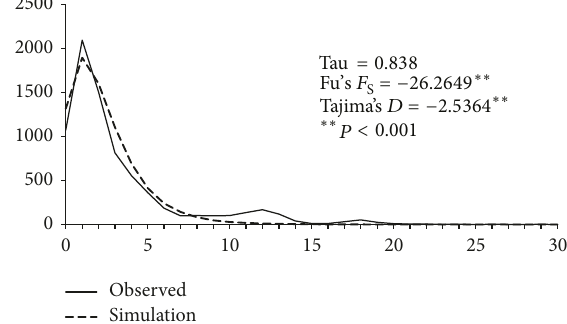
Figure3:Mismatchdistributionof124mitochondrialcytochromeb (cytb) sequencesof Belodontichthystruncatus representingobserved and expected pairwise differences under sudden population expan- sionmodel.Mismatchdistributionfor B.truncatus isconsistentwith predictions of sudden population expansion model (SSD = 0.0047, 𝑃 = 0.4750 ; Harpending’s raggedness index = 0.0349, 𝑃 = 0.5270